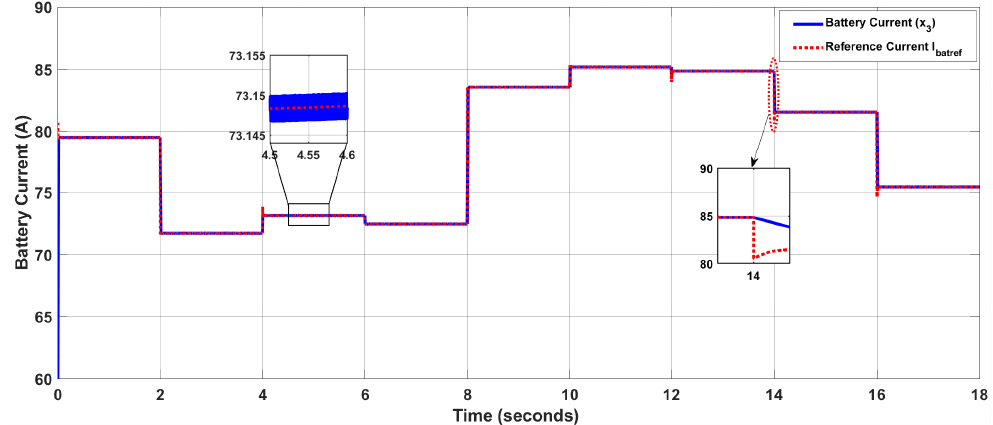
Figure 15. Battery current x 3 (case-II).